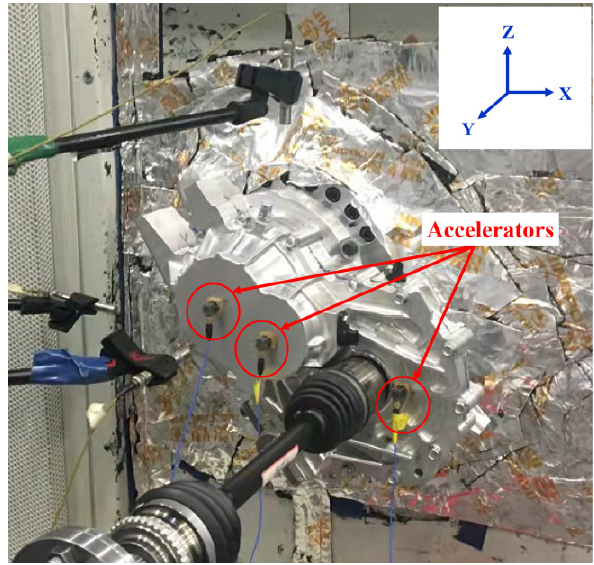
Figure 7. Housing vibration measurement positions and measurement coordinate setting.